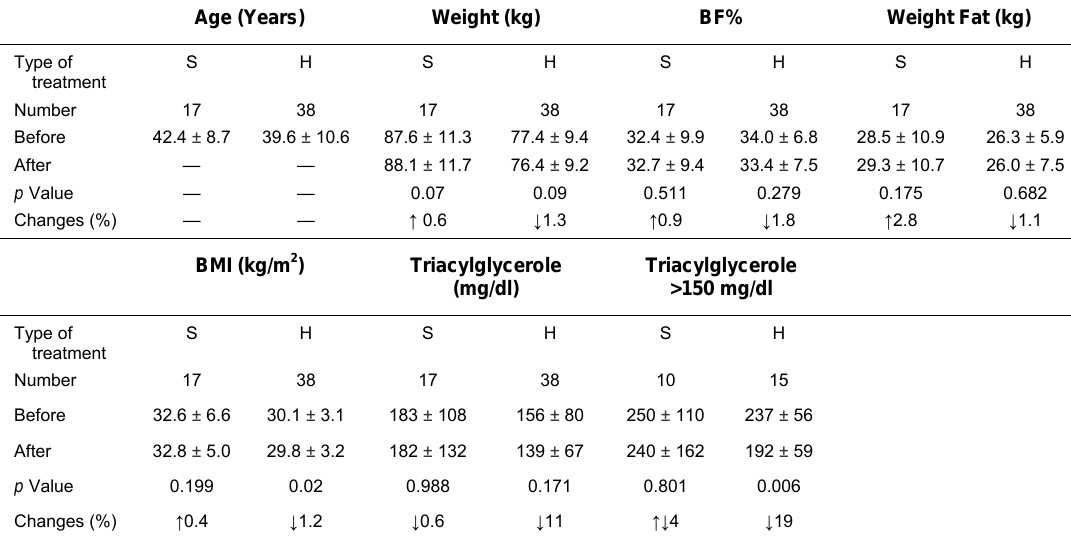
Effects of Sucrose and Honey on Anthropometric Measurements and Serum Triacylglycerole